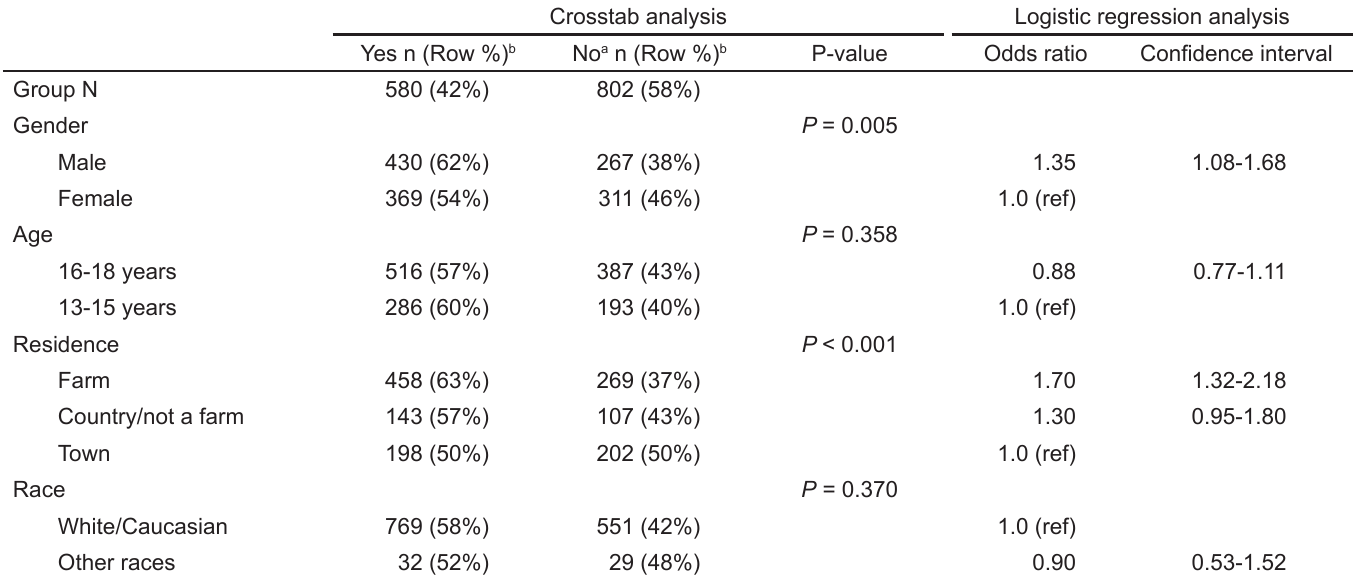
Table 3. Bivariate and multivariable logistic regression analyses regarding the presence of handguns in the homes of adolescent survey